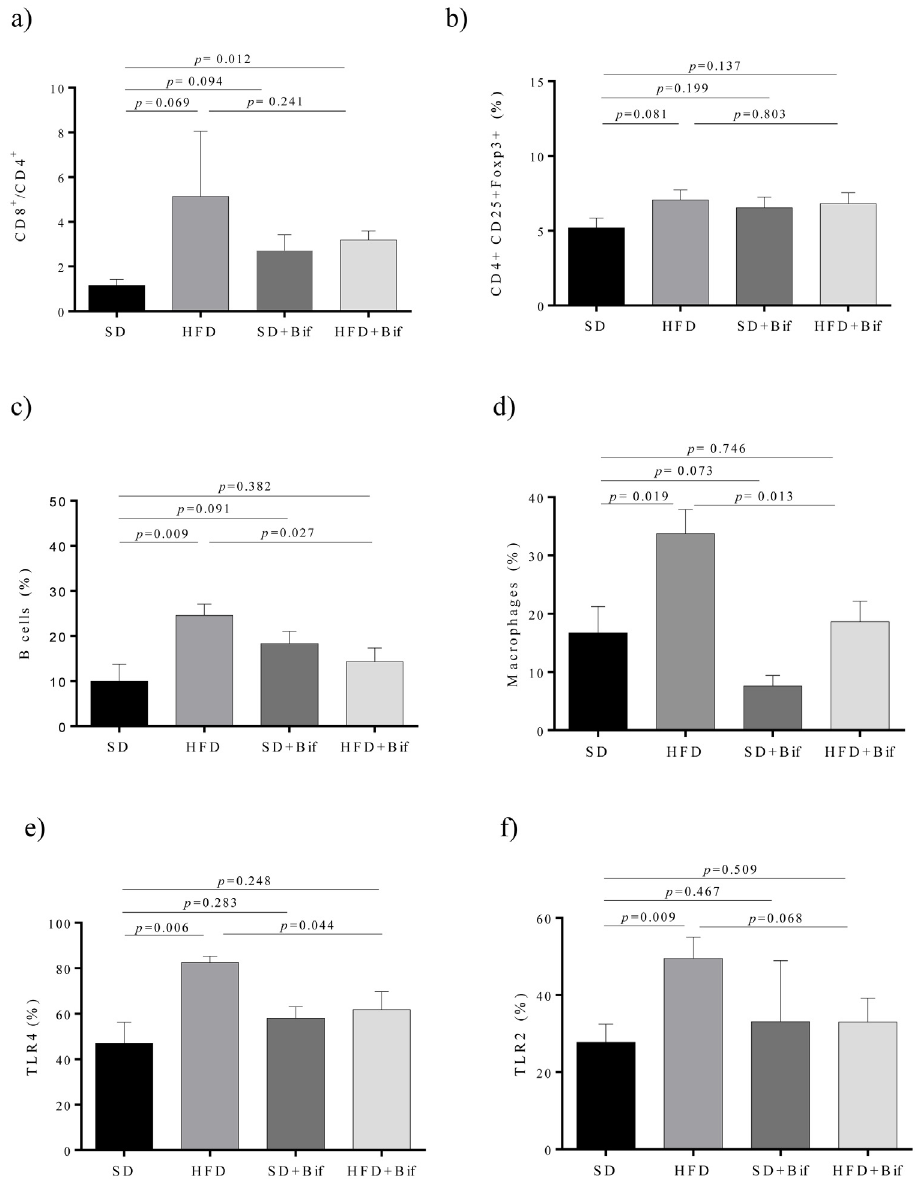
Fig 5. Lymphocyte and macrophage infiltration and TLR4/2 expression in mesenteric lymph nodes (MLNs) from small intestine of different mouse groups after 14 weeks of dietary intervention.